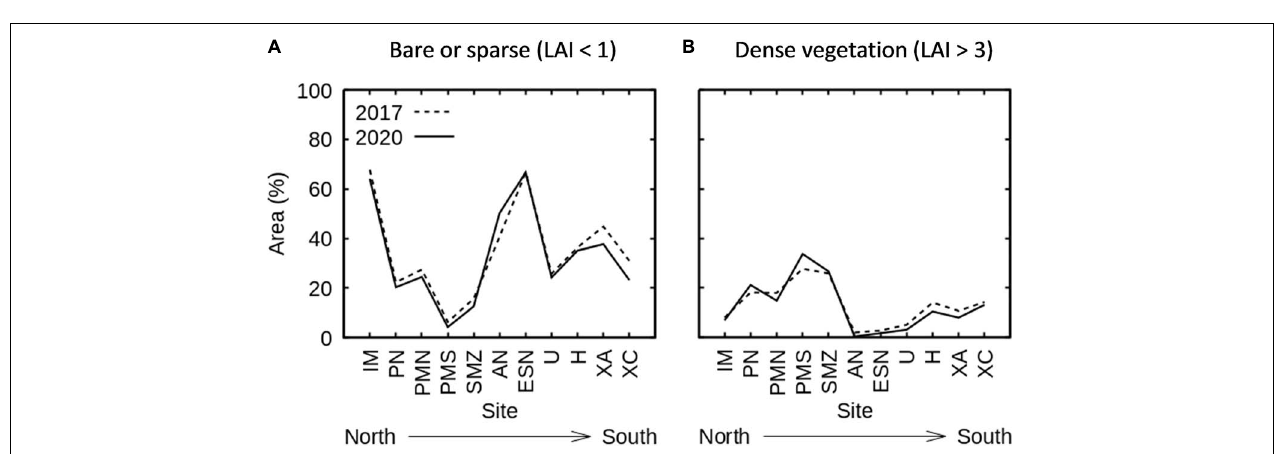
FIGURE 11 | (A) Relative distribution of estimated LAI versus depth over the lagoon area ( ∼ 825 km 2 ) for 2017. Data has been evenly stratified by LAI in bins of 0.5, to show the relative occurrence of LAIs at specific depths. Lines are upper limits of LAI from local field survey (EOCH2019, Eq. 1), and the extended model (Eq. 2) (see Figure 3 ). (B) Histogram showing areal cover as a function of LAI for 2017 and 2020. Shaded area is LAI > 3 and represents 43.1 km 2 for 2019 and 36.4 km 2 for 2020.